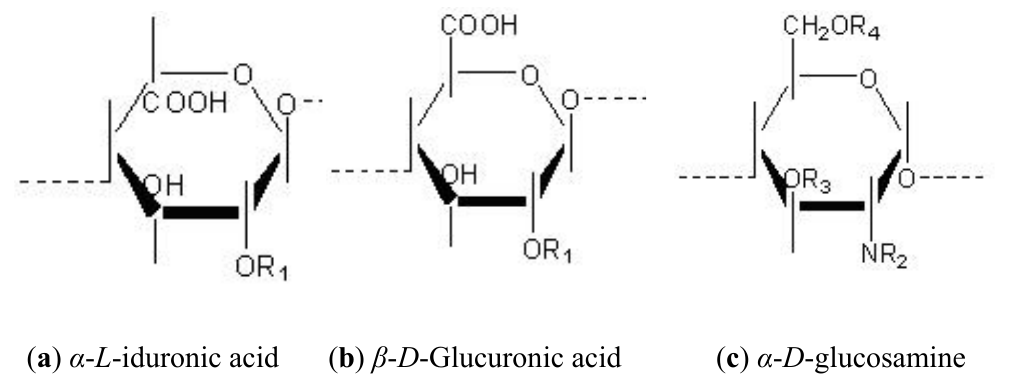
Figure 2. Individual monosaccharide units of heparan sulphate. The repeating dissacharide unit is composed of either α -L-iduronic acid (a) or glucuronic acid (GlcA) (b) and a N-acetylglucosamine residue (GlcNAc) (c). Various biosynthetic modifications can occur on the R positions of the monosaccharide units, involving functional groups, H- hydroxyl, COCH3- acetyl groups and SO3 − sulphate groups. R1=H or SO3 −